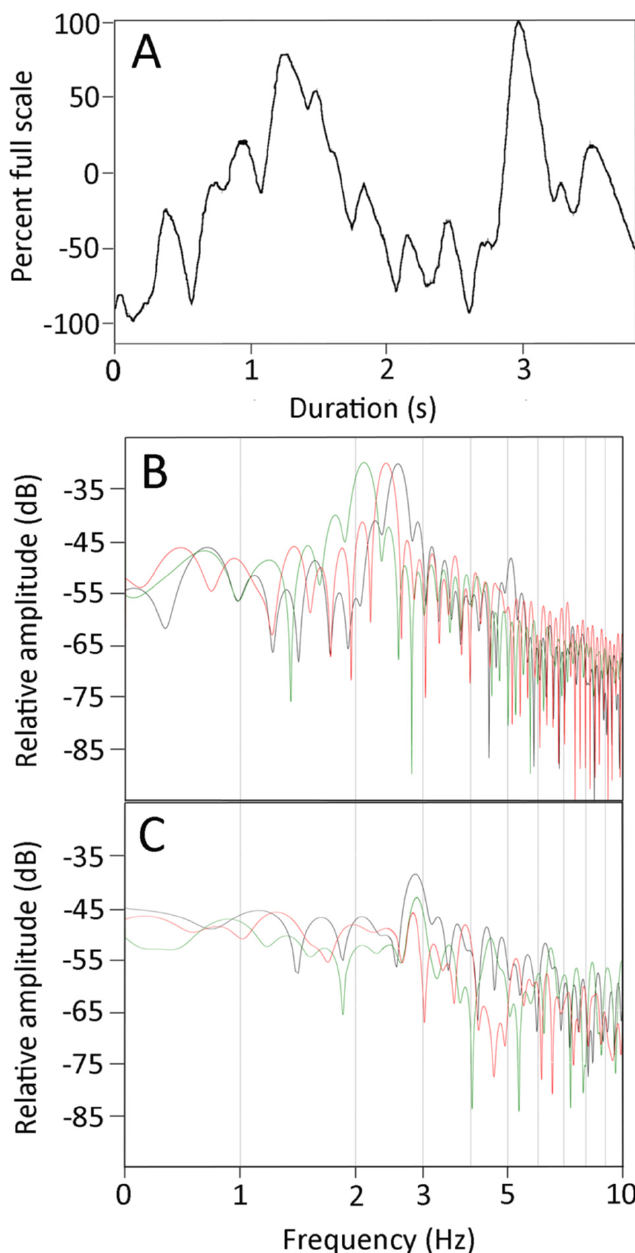
Figure 4. ( A ) Plot of the cranial CSF pressure (Y axis) over time (X axis) during a manual oscillation trial. These pressure traces were characterized by discrete pulses which occurred at frequencies well above those of the ventilatory (0.08 Hz) or cardiac (0.66 Hz) pulses evident in Figure 1A or Figure 3C, and are similar to the 3 Hz frequency of the body oscillations shown in Figure 3B. ( B ) Power spectral analysis of the kinematics from three manual oscillation trials of one specimen. ( C ) Power spectral analysis of the CSF pressure traces from the same three manual oscillation trials. Note the relative similarities of the dominant frequencies (2–3 Hz) and the decrease in spectral power at higher and lower frequencies; the lower frequencies of the CSF pressure are prominent owing to the presence of the cardiac and ventilatory